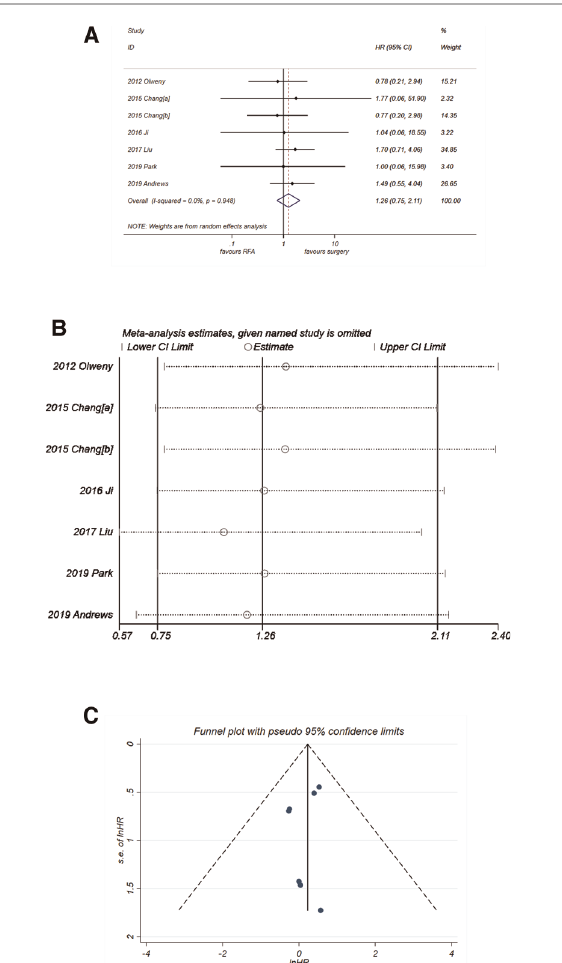
FIGURE 4 Comparison of PFS of RFA vs. PN. ( A ) The forest plot shows the HR of PFS of RFAvs. PN. HR>1 indicates that RFA has higher risk for PFS. ( B ) Sensitivity analysis was performed by omitting one study at each analysis. The result of each analysis is also presented as the forest plot. ( C ) The funnel plot was used to detect publication bias. PFS, progression-free survival; RFA, radiofrequency ablation; PN, partial nephrectomy; HR, hazard